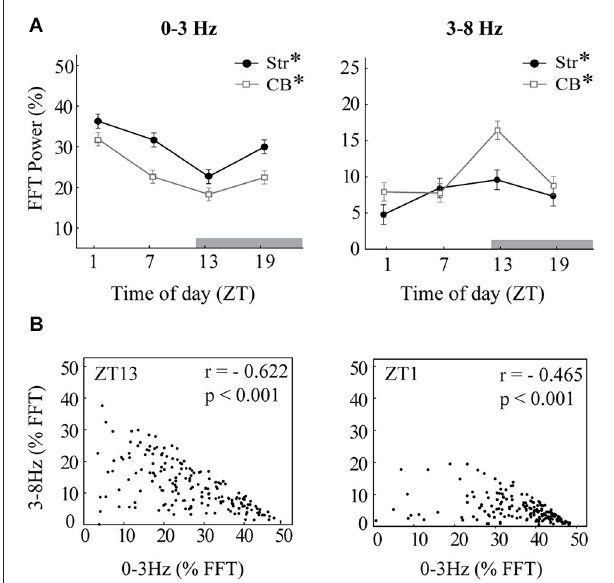
FIGURE 3 | Diurnal variation in oscillations. (A) The mean integrated power of 0–3 Hz oscillations (left) and 3–8 Hz oscillations (right) is shown for each time of day at baseline, before raclopride administration, expressed as a percentage of the total power spectrum (0–55 Hz). Time of day (ZT) is expressed in hours after onset of light. Note that the dark period began at ZT12 (gray bar). Asterisks indicate significant effects of ZT ( p < 0.05). (B) Scatterplots indicate strong negative correlations between the power of 0–3 Hz oscillations and 3–8 Hz oscillations. Each dot represents the integrated power within each of the 2-s windows that compose the baseline recordings. The panel at left shows an example from ZT13 that includes both 1 Hz oscillations and 4–5 Hz oscillations. The panel at right shows an example from ZT1 that contains mainly 1 Hz oscillations. Both examples are from striatal LFPs, though cerebellar LFPs showed a similar